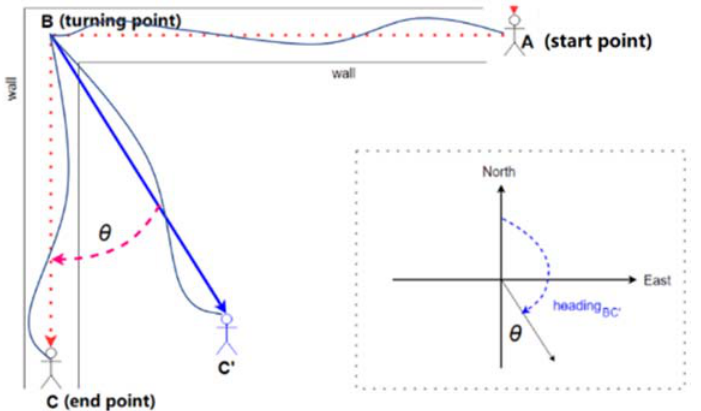
Figure 15. A sketch of heading optimization based on non-steady-heading activities (such as turn- ing).